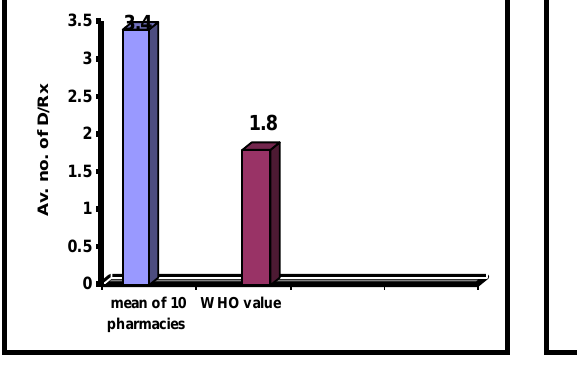
Figure 3: Comparison of the mean of percent AB/Rx of 10 pharmacies with WHO standard value.